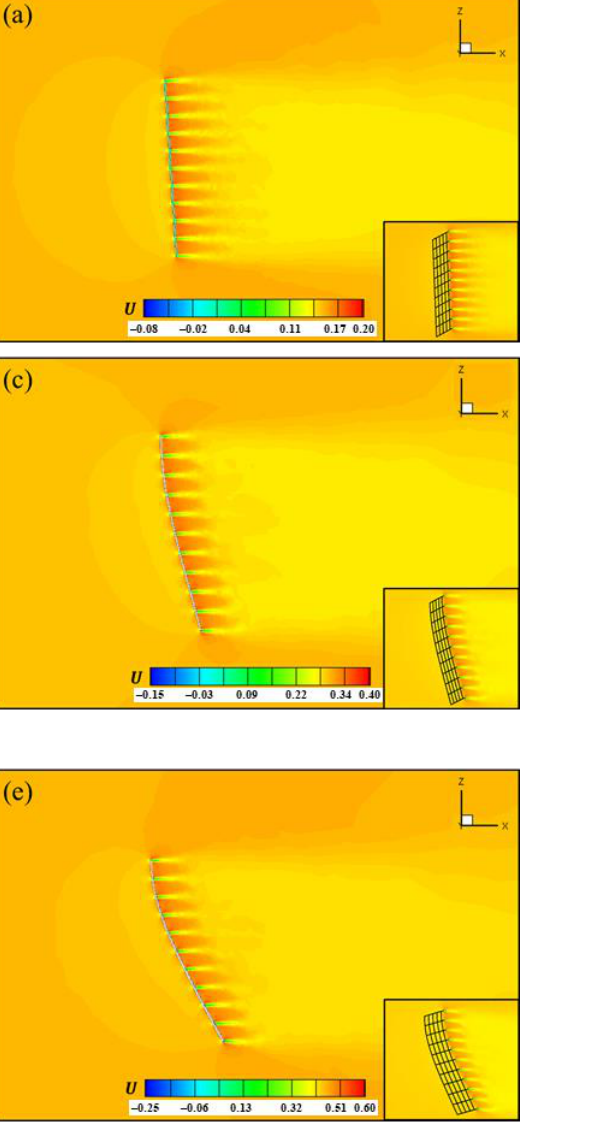
Figure 5. Velocity distributions of the flow at the angles of attack between π /3 and π /2 for net solidities Sn = 0.16 ( left column) and Sn = 0.33 ( right column): ( a , b ) U ∞ = 0.15 m/s; ( c , d ) U ∞ = 0.30 m/s; ( e , f ) U ∞ = 0.45 m/s.